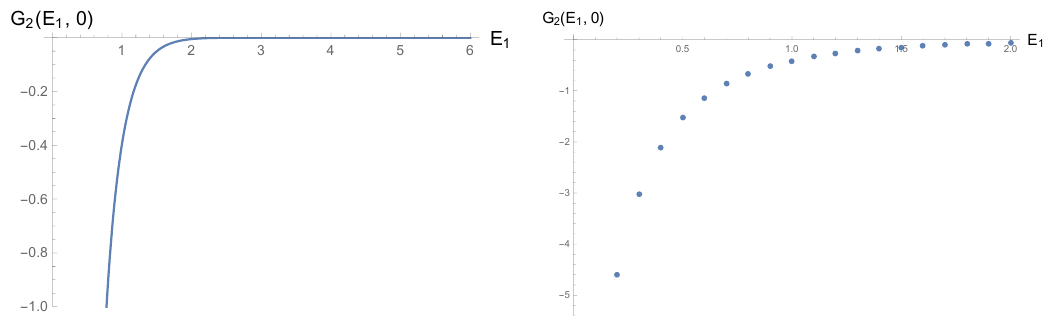
Figure 4 . Left: the genus zero connected eigenvalue correlation function for (cid:22) = 1 ; E 2 = 0. Right: the behaviour of the non-perturbative correlation function is quite similar at short spacings.